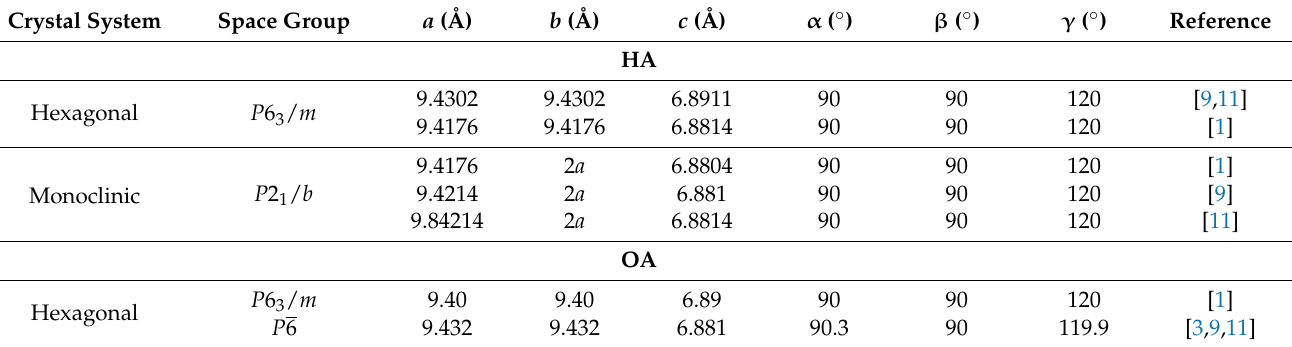
Table 1. Structural parameters of the hydroxyapatite (HA) and oxyapatite (OA) reported in the literature. Crystal System Space